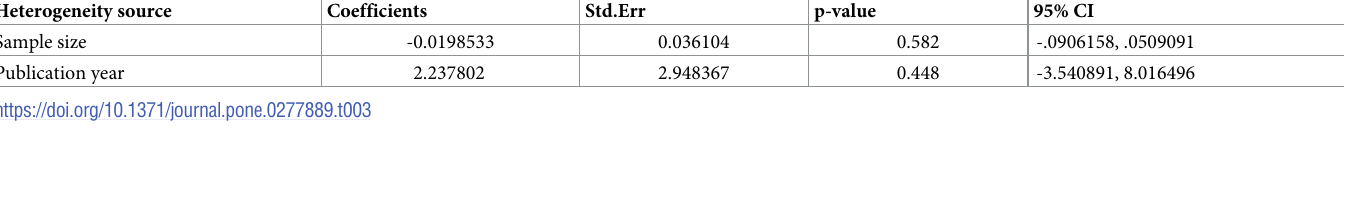
Table 3. A univariate meta-regression analysis of factors affecting between-study heterogeneity. Heterogeneity